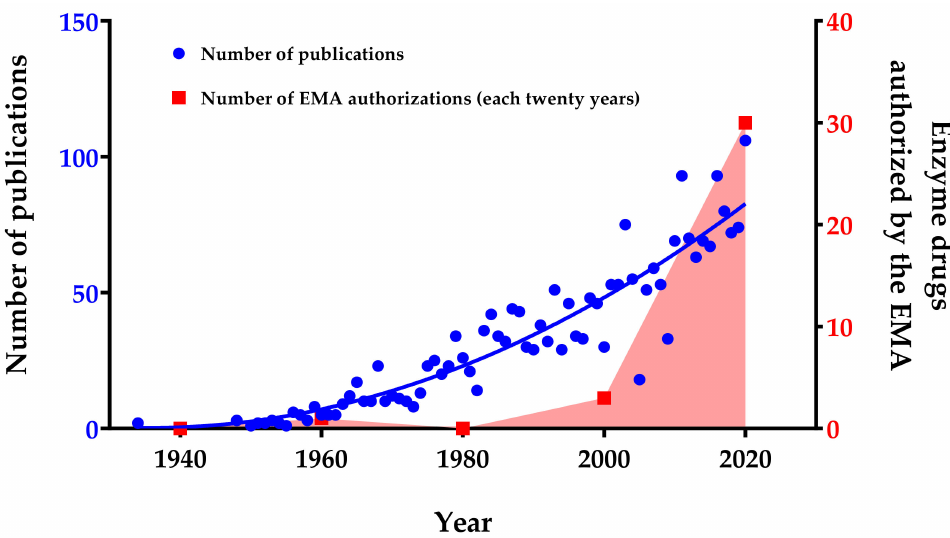
Figure 1. Number of publications and enzyme drugs authorized per year (from 1934 to 2020). Publication searches were performed by entering the subject “enzyme therapy, drug and treatment” in PubMed database and choosing the field “Title/Abstract” to filter the search. The enzyme drug searches were performed in the European Medicines Agency (EMA, Amsterdam, The Netherlands) database, and the number of authorized enzymes per twenty-years’ time intervals was plotted. Red area only highlights the growing trend in the number of enzymes authorized by the